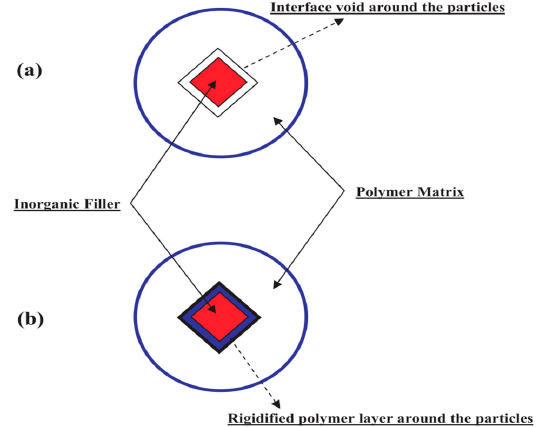
Figure 3. Schematic diagram of non-ideal MMM morphologies. Interface void ( a ) and rigidified polymer layer ( b ) in the polymer–particles interface. Reproduced with permission from Ref. [77] Copyright 2010